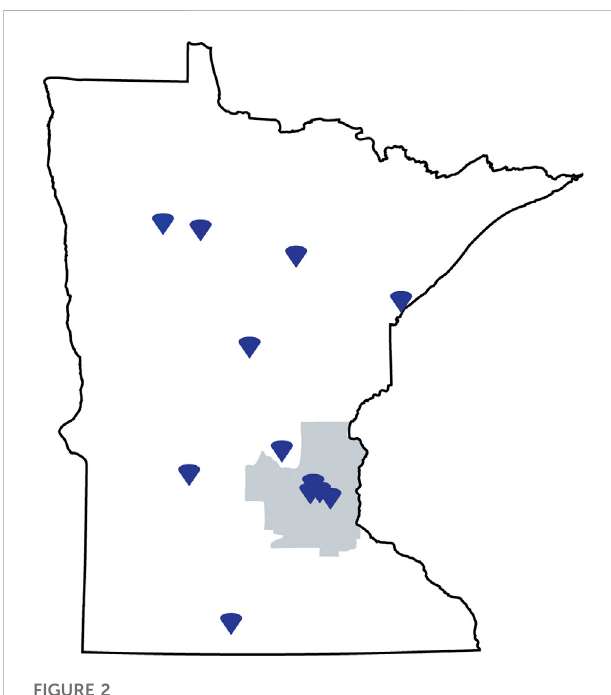
FIGURE 2 State ofMinnesotamap indicating location oflearnerspractice